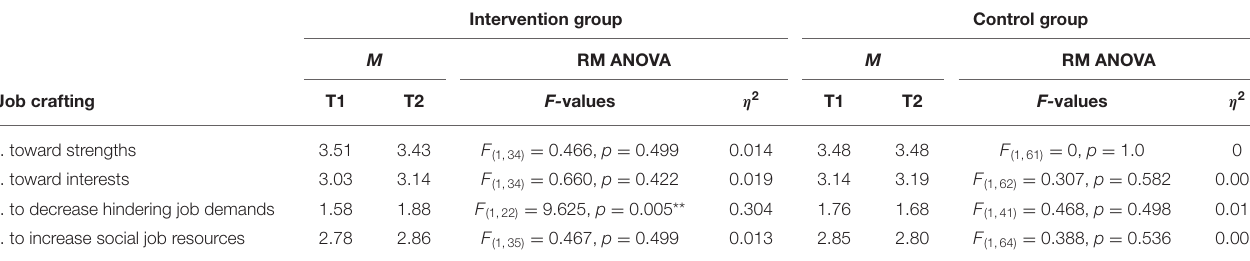
TABLE 2 | Results of RM ANOVAs job crafting ( n control = 50; n intervention = 38). Intervention group Control group M RM ANOVA M RM ANOVA T1 T2 F- values η 2 T1 T2 F- values η